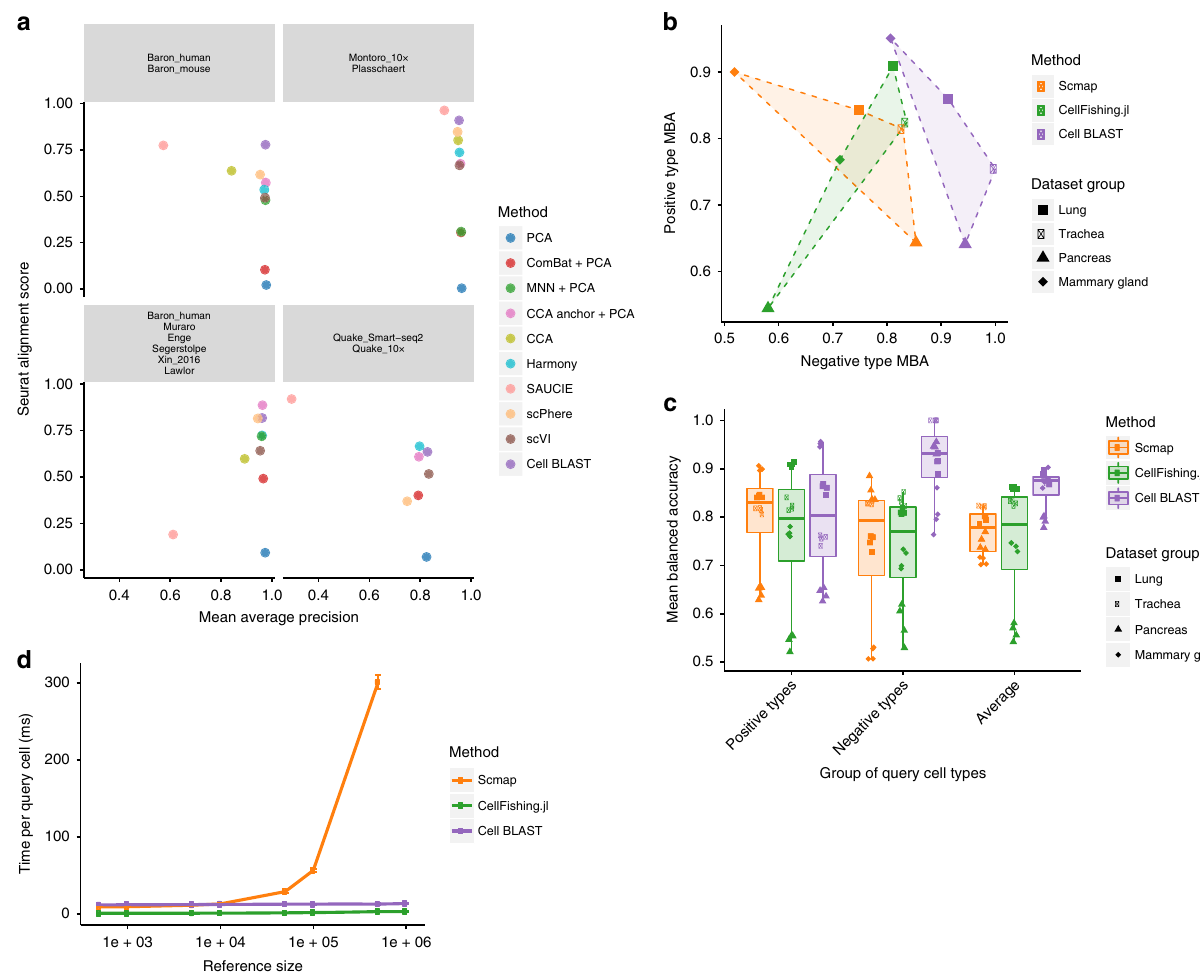
Fig. 2 Cell BLAST benchmarking. a Extent of dataset mixing as measured by Seurat alignment score, versus cell-type resolution, as measured by mean average precision, after batch effect correction in four groups of datasets. Both scores range between 0 and 1. Speci fi cally, a high Seurat alignment score indicates that local neighborhoods consist of cells from different datasets uniformly rather than from the same dataset only, i.e., different datasets mix well. Meanwhile, mean average precision can be thought of as a generalization to nearest-neighbor accuracy, with larger values indicating higher cell-type resolution. It is reported to ensure that dataset mixing does not blur the true biological signal. CCA and MNN failed in the last dataset due to memory errors. b MBA of query-based cell typing on positive versus negative queries. Points of the same method are outlined for clarity. As CellFishing.jl does not come with a query-based prediction method, we used the same strategy as Cell BLAST, with Hamming distance = 120 as cutoff determined from grid searching for best balance between correctly predicting positive types and rejecting negative types across all four datasets (see “ Methods ” and Supplementary Fig. 8a, c for more details). c MBA of query-based cell typing on positive and negative queries as well as their arithmetic average ( n = 16 experiments across four query groups for each method). Box plots indicate the median (center lines), 1st and 3rd quartiles (hinges), minimal and maximal point within 1.5 times the interquartile range starting from the hinges (whiskers). d Querying speed on reference datasets of different sizes